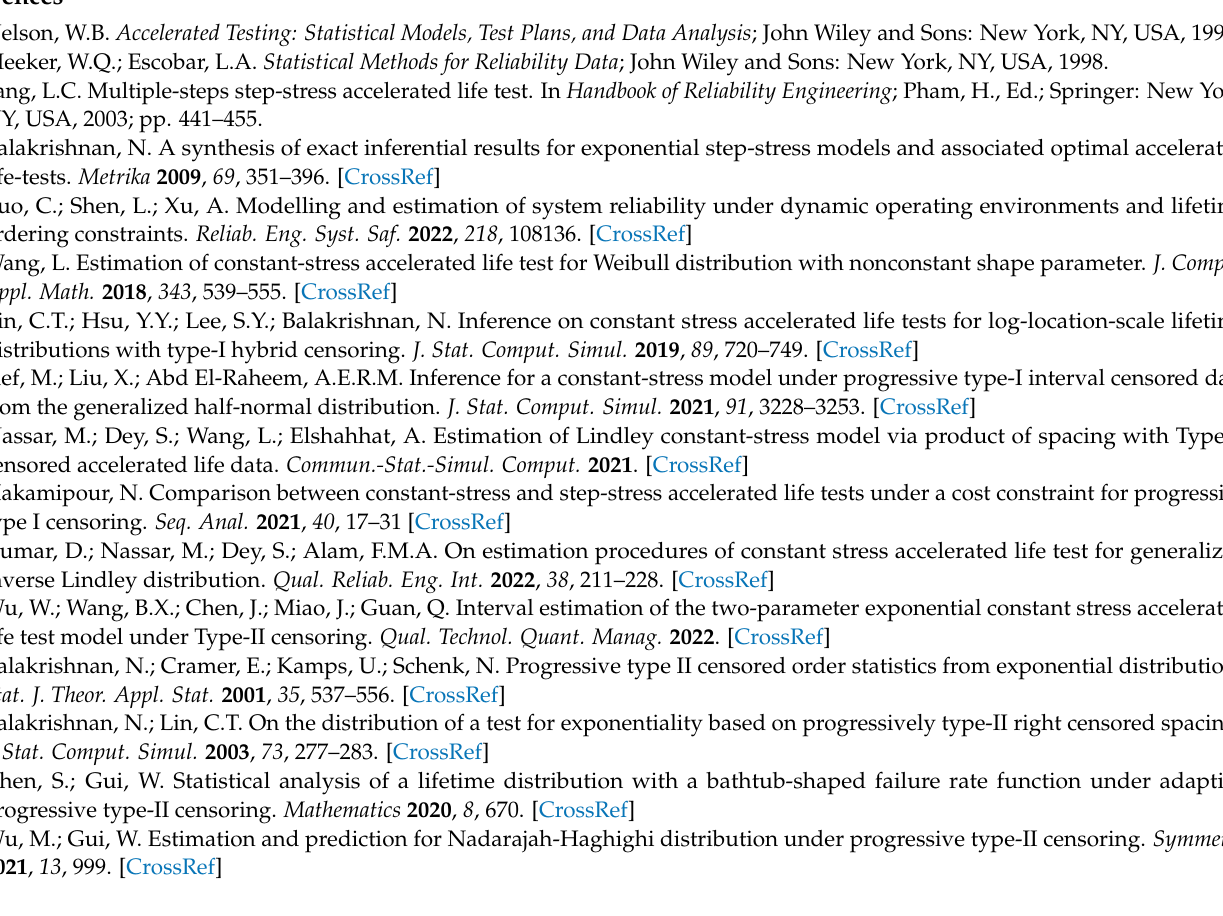
Table S8: The ACLs (1st column) and CPs (2nd column) of 95% ACI/BCI of α u ; Table S9: The ACLs (1st column) and CPs (2nd column) of 95% ACI/BCI of ¯ G u ( t ) ; Table S10: The ACLs (1st column) and CPs (2nd column) of 95% ACI/BCI of H u ( t )